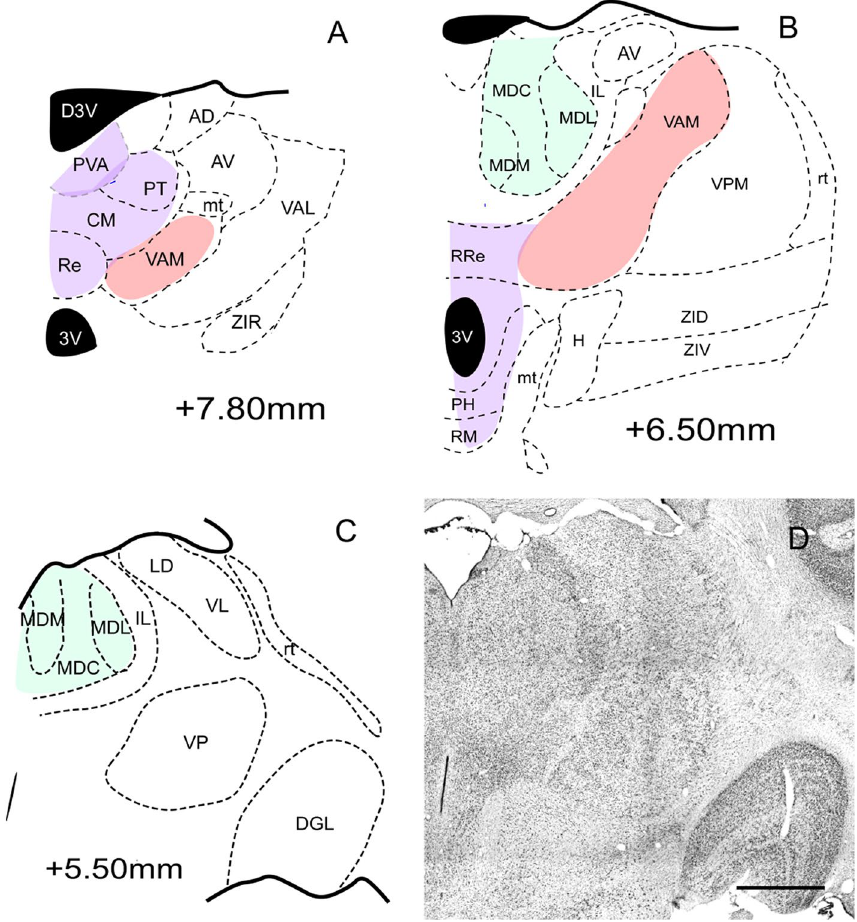
Figure 5. (A–C) Schematic draws representative coronal sections of the marmoset diencephalon; The main targets of A25 and A32 is represented by regions in colors ; ( C ) Schematic draw based on coronal section of the Nissl presented in ( D ); Scale bar: 1000 µm . The figure was drawn in Canvas software version 12.0 76